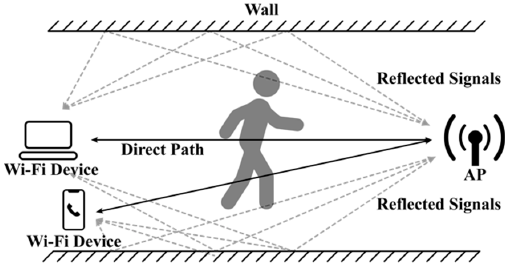
Figure 1. Multipath propagation of Wi-Fi signal indoors.